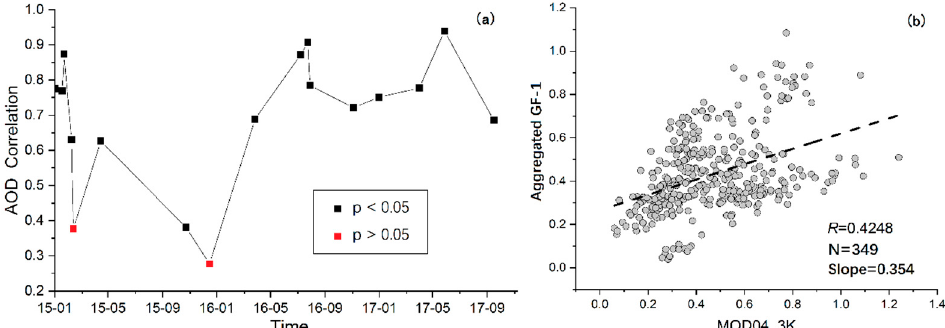
Figure 3. Correlation between the aggregated Gaofen-1 (GF-1) aerosol optical depth (AOD) and the MOD04_3K AOD: ( a ) only dates for which both types of AOD data were available, and ( b ) for the whole study period.